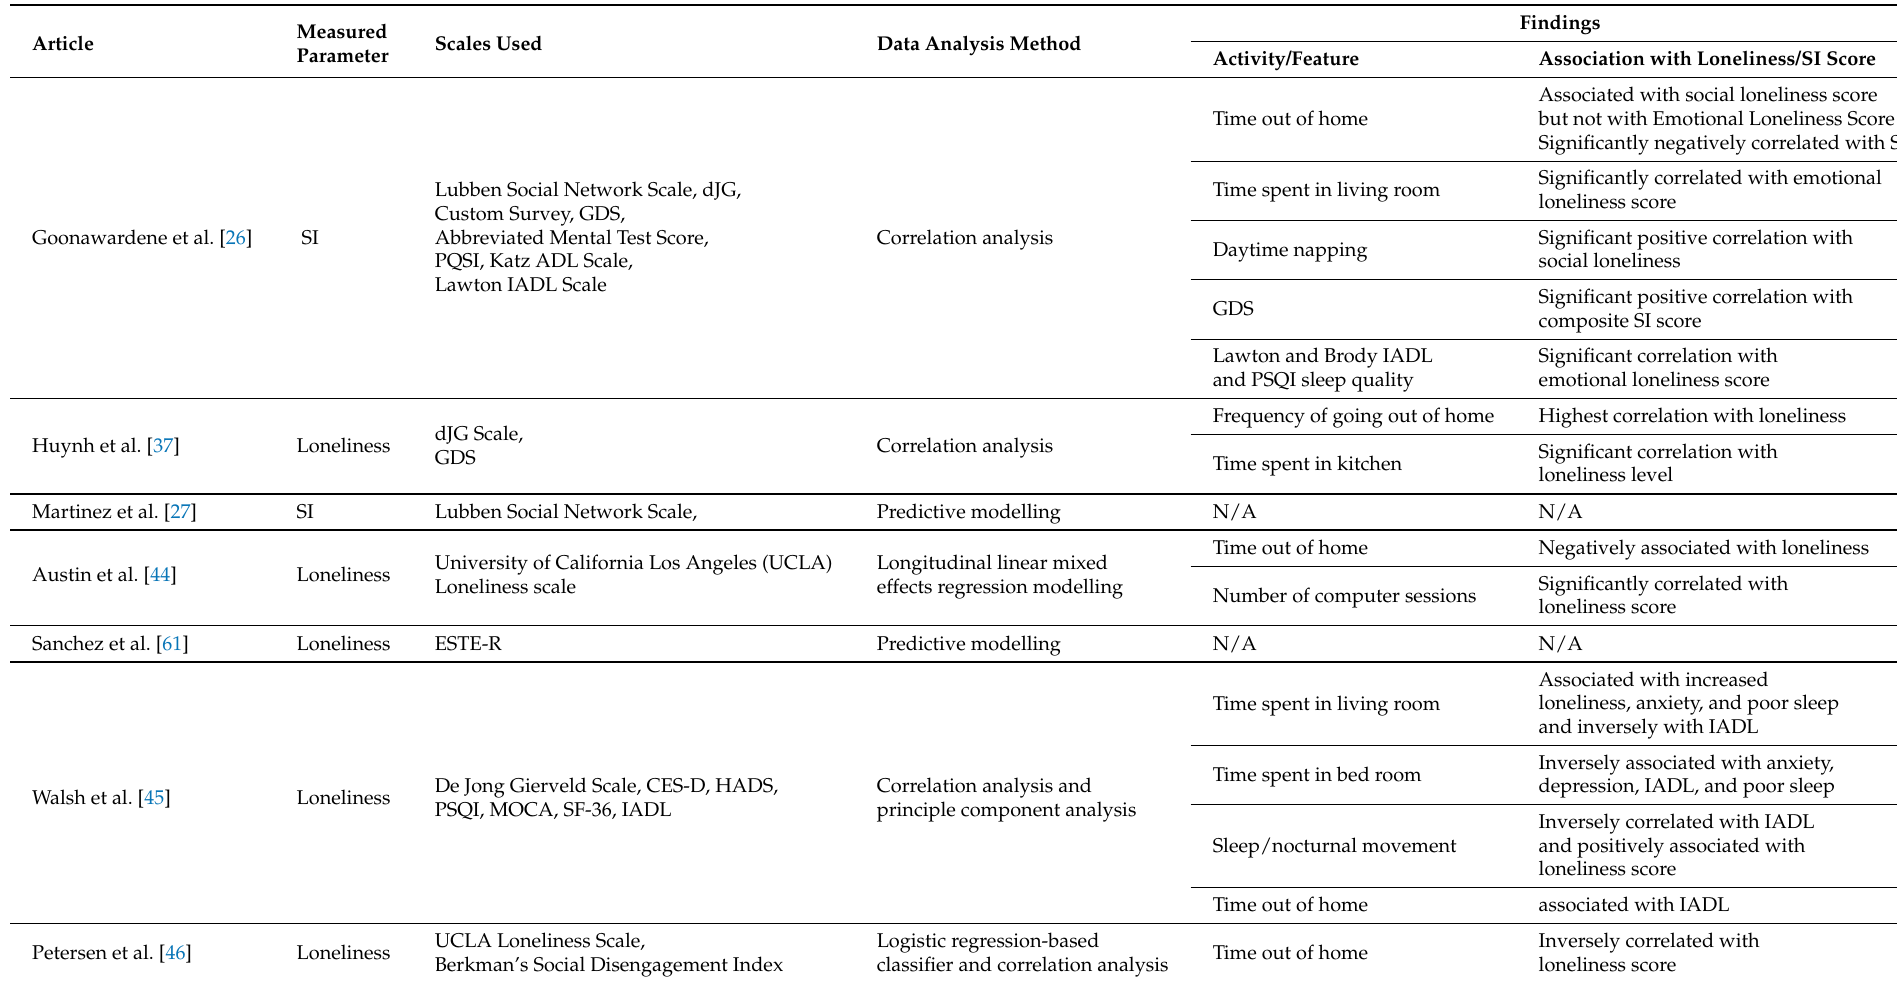
Table 7. Summary of data analysis methods and key